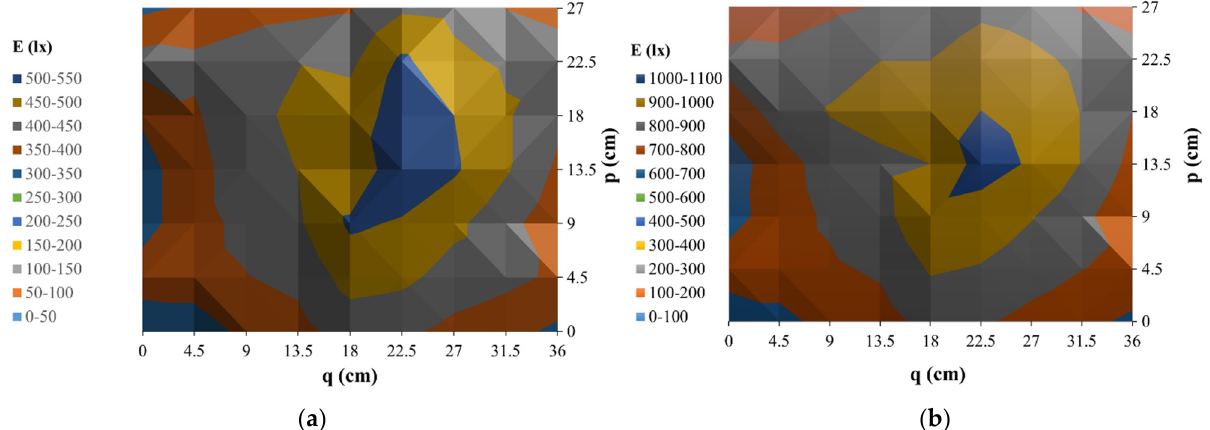
Figure 8. Distribution of the illuminance of the Ring XRE module for the value of E zad equal to 500 lx ( a ) and 1 klx ( b ).